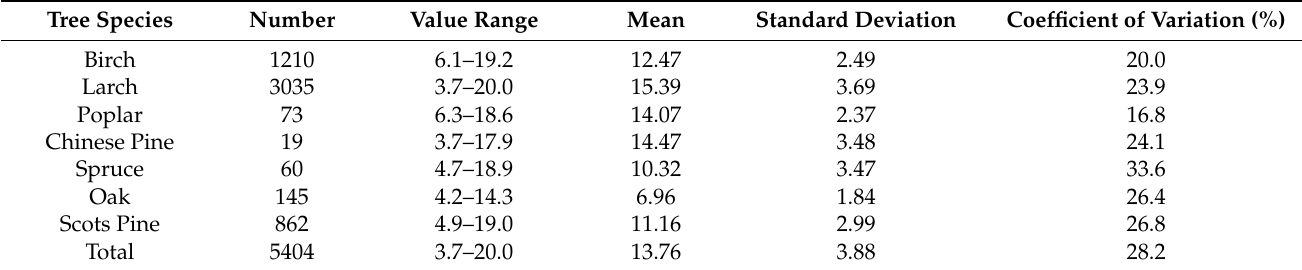
Table 1. List of tree species measured in Saihanba.